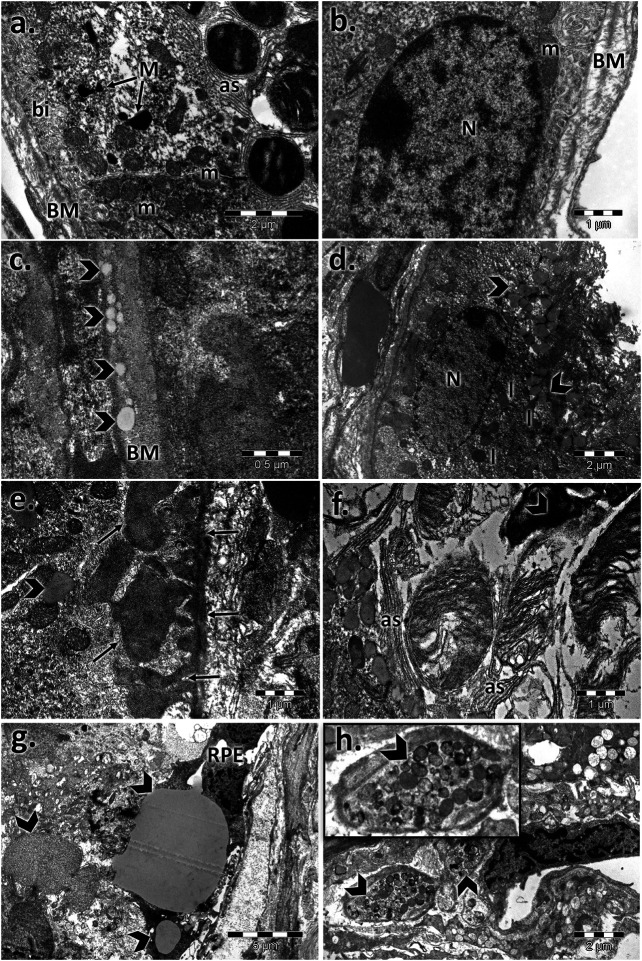
Electron micrographs showing the ultrastructural features of the retinal pigment epithelium (RPE) of the aged male retina. (A,B) RPE of the male control, showing the normal aspect of the nucleus (N), mitochondria (m), melanin granules (M), Bruch’s membrane (BM), marked basal infolding (bi), and wide apical sheaths (as) surrounding the photoreceptor outer segments; (C–H) RPE of the aged male, showing changes in the RPE ultrastructure, highlighted by thickened Bruch’s membrane (BM) enriched in lipids (arrowhead) (C); lipid drops accumulated in the cytoplasm and crowded in the apical sheath area (arrowhead), lipofuscin (l) (D); localized thickening of Bruch’s membrane on the RPE side and fingerlike extensions of the amorphous material (arrows) (E); atrophic apical sheaths (as) (F); large lipid drops (arrowhead) and atrophied retinal pigment epithelial layer (RPE) (G); clusters of melanosomes and lipofuscin (arrowhead) (H). Figures are representative of n = 10 electron micrographs for each individual/group.